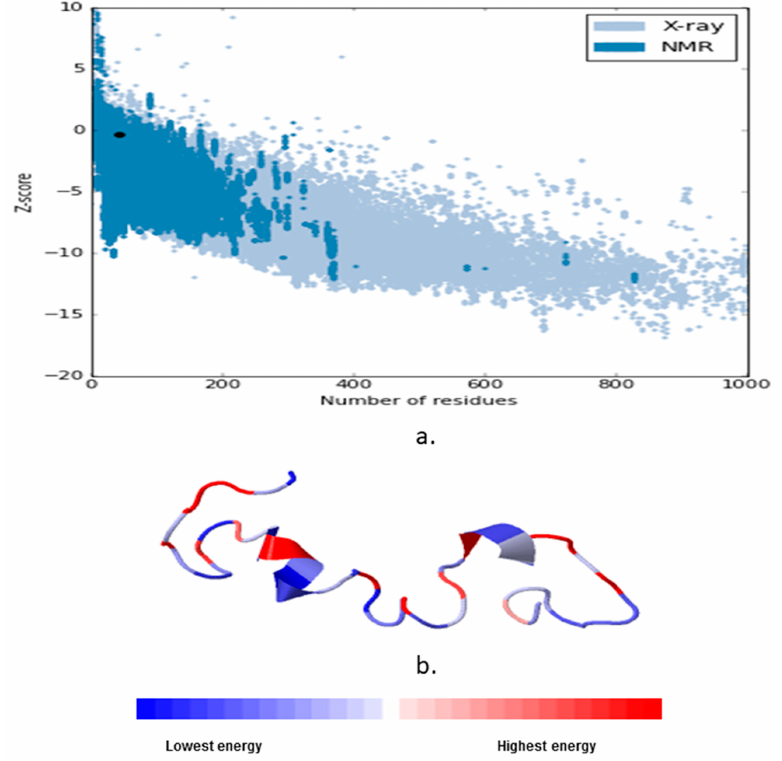
Figure 2. ( a ) The protein structure analysis (ProSA)-web for validation of the experimental protein structures, structure prediction, and modeling. The quality scores of the protein homology modeled tau showed good quality with a Z-score − 0.39 with dark dots indicating real experimental quality such as NMR and X-ray crystallography; ( b ) ProSA-web visualized the 3D structure of the modeled, tau protein residues are colored from blue to red in order of increasing residue energy. The tau modeled residue energy distribution was entirely below the zero base line, consistent with the residue number.